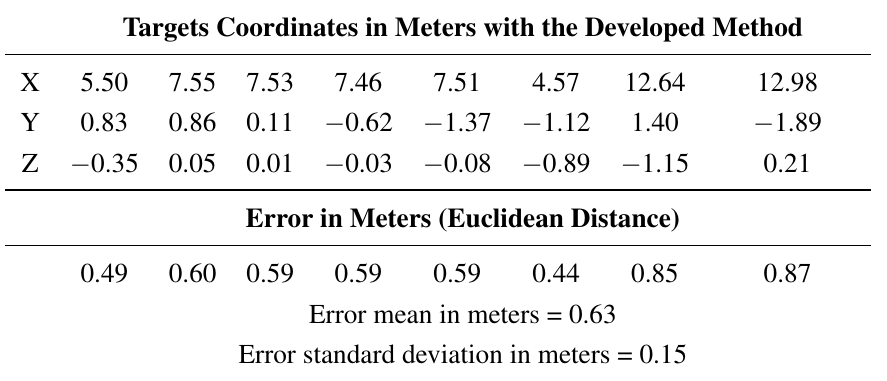
Table 3. Reconstruction results in m using the second calibration